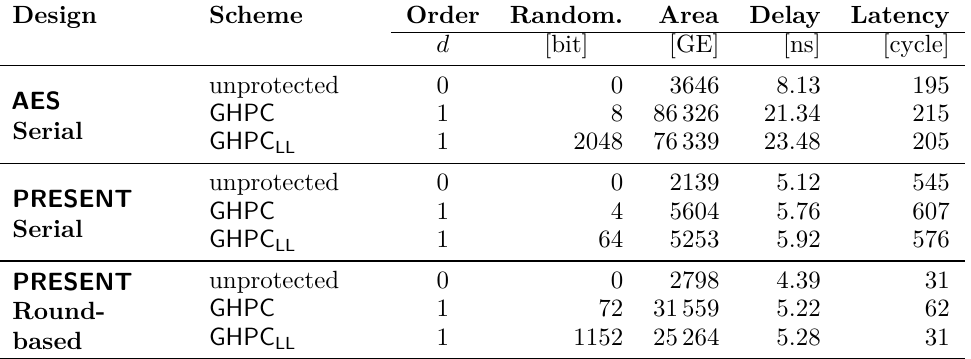
Table 2: Performance figures of our case